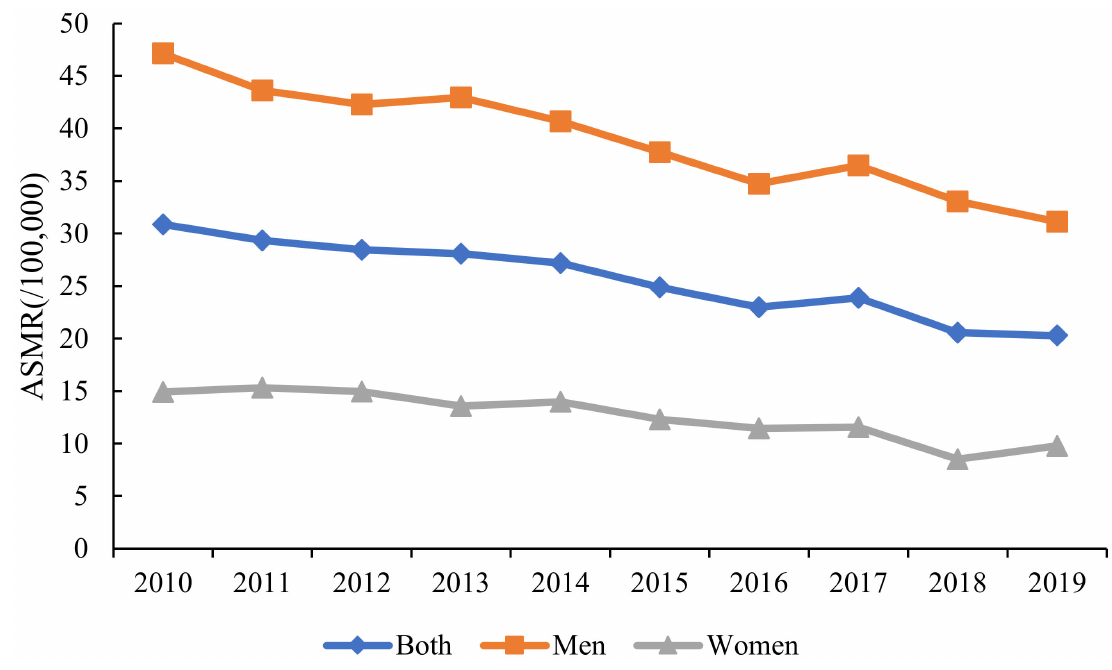
Figure 1. The Trends in the ASMRs of Liver Cancer in Wuhan from 2010 to